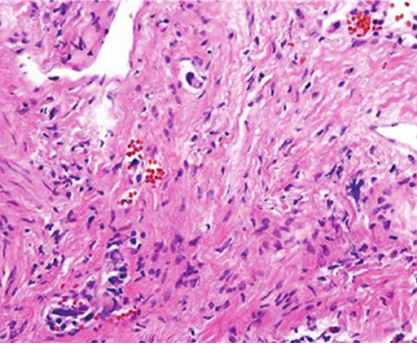
Figure 2: H&E, 40x. Atypical cells within a lymphatic lumen. The atypical cells have abundant cytoplasm and large nuclei with prominent nucleoli.